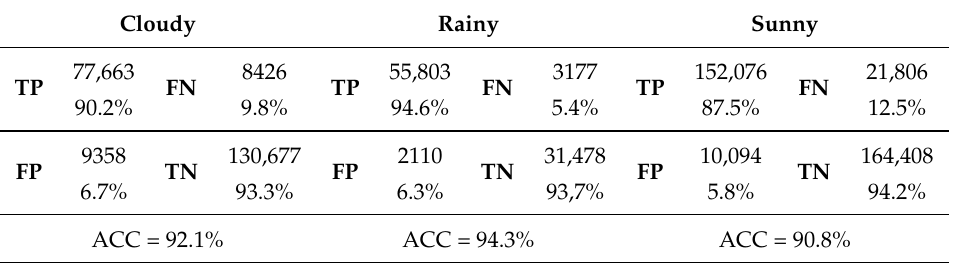
Table 4. PKLot dataset: confusion matrix for different weather conditions, threshold t 2 =